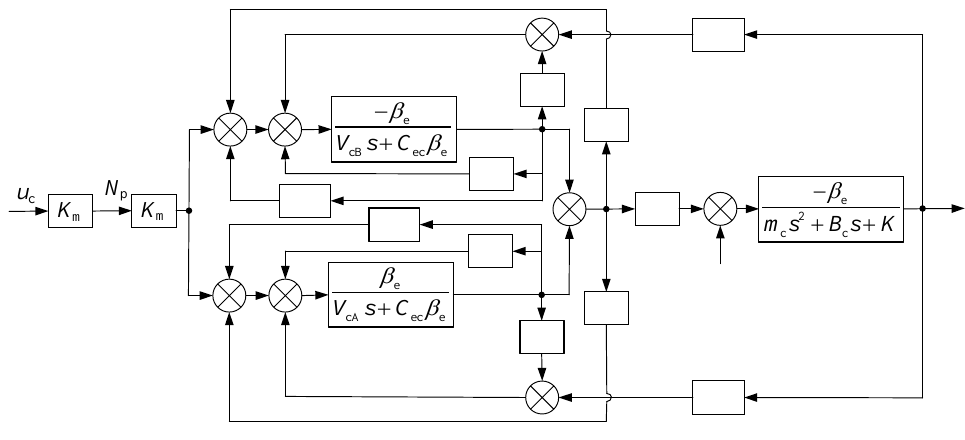
Figure 3. Block diagram of pump control system.